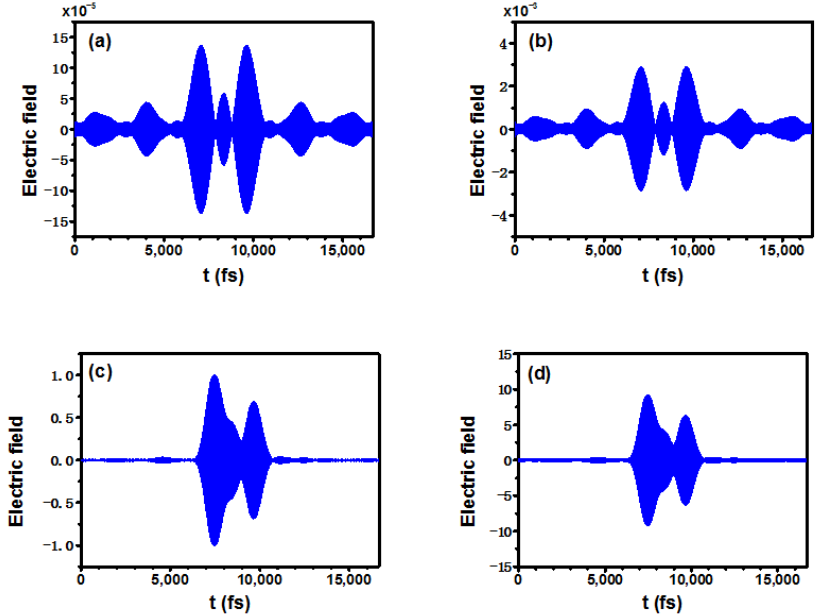
Figure A8. Real part of the electric field of ( a , b ) the Stokes, and ( c , d ) anti-Stokes pulse when the step position of the Stokes light scans to 12,187 cm − 1 . ( a ) The input and ( b ) output of the Stokes pulse at the probe point of the disk-ring structure. The anti-Stokes pulse ( c ) in air and ( d ) at the probe point in the disk-ring structure.